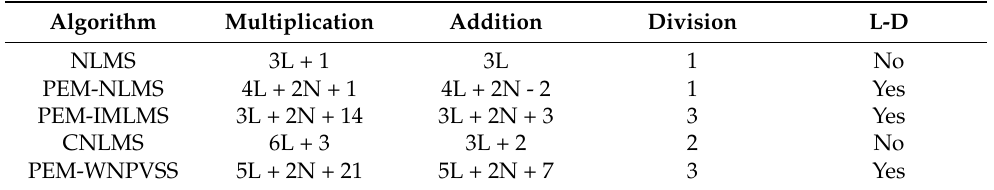
Table 1. Computational complexity of the five algorithms in simulation.